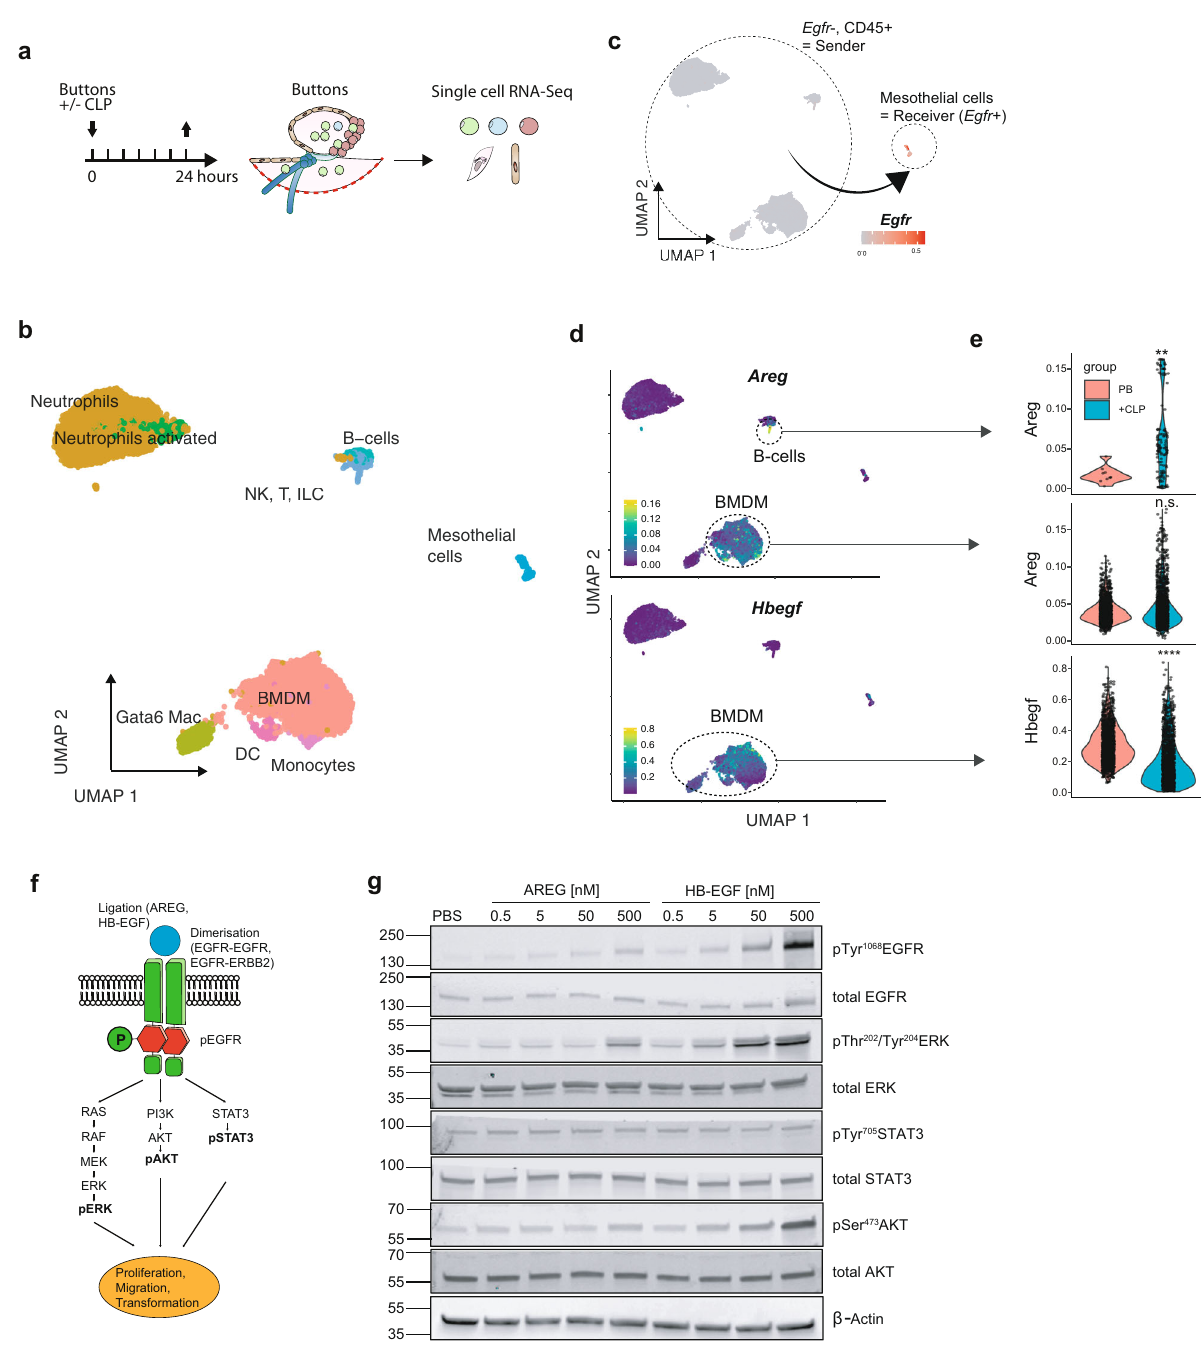
Fig. 5 EGFR-ligands are produced by bone-marrow derived macrophages and a B-cell subset that are recruited to the wound. a Illustration of single cell RNA-Sequencing experimental approach. Single cells were isolated from peritoneal buttons (PB) with or without cecal ligation and puncture (CLP). b – d UMAP plots colored by cell cluster ( b ), expression of epidermal growth factor receptor ( Egfr) ( c ), expression of amphiregulin ( Areg ) and heparin- binding epidermal growth factor ( Hbegf ) respectively ( d ). e Expression of Areg and Hbegf by cell cluster and condition. Differential expression testing with FindMarkers function (Seurat). ** P < 0.01, **** P < 0.0001, n.s. P ≥ 0.05. f Schematic illustration of signaling pathways downstream of EGFR. g Western blot stained for phospho-EGFR and the respective downstream molecules illustrated in ( f ). Primary mesothelial cells were incubated with amphiregulin (AREG) and heparin-binding epidermal growth factor (HB-EGF) with the indicated doses for 20 min. Single-cell data represents a pooled data set of n = 4 mice ( n = 2 with CLP, n = 2 injury alone). The immunoblot shown in ( g ) represents two independent experiments. Raw data were deposited at gene expression omnibus (GSE186658) and Source Data are provided as Source Data